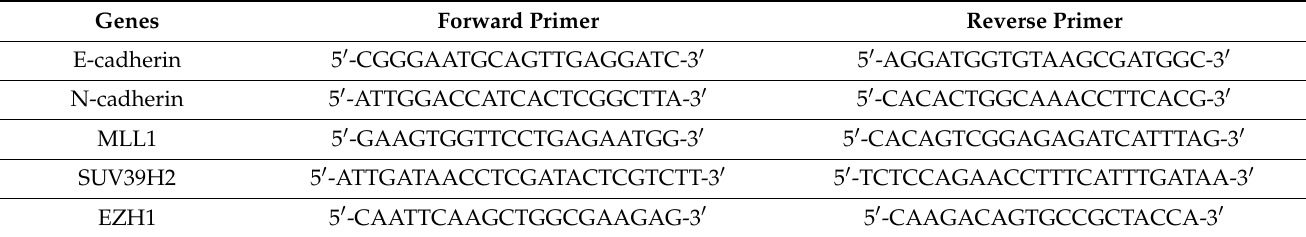
Table 1. The table represents the genes and their respective forward and reverse primer sequences used for qRT-PCR